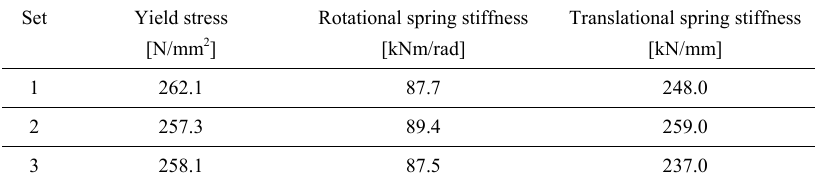
Table 4: Calibration parameters. Set 1 corresponds to experiment 1,